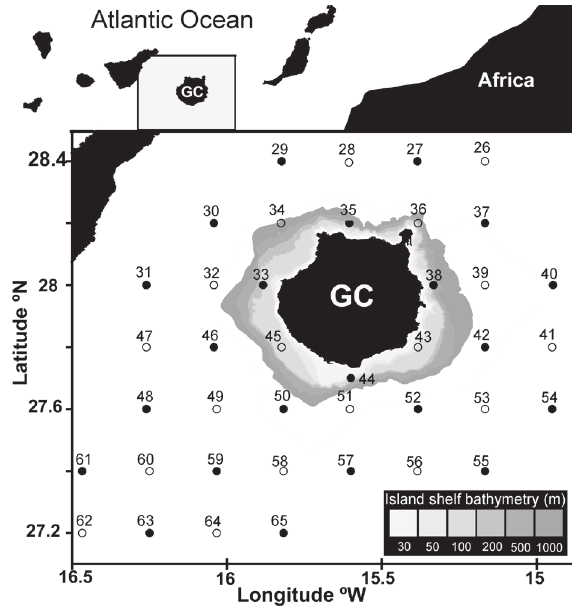
Fig . 1. – Location of the grid of ctd stations around gran canaria (gc). the filled symbols correspond to stations sampled for plank- tonic invertebrate